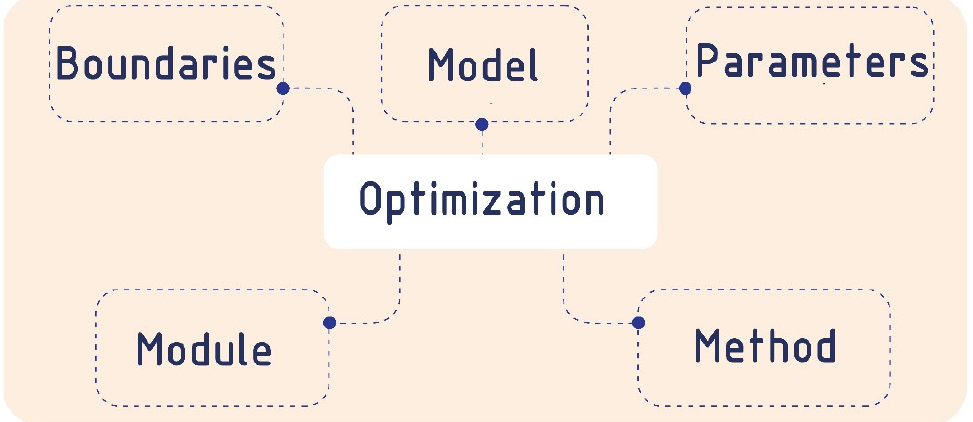
Figure 1. The necessary components of optimization.